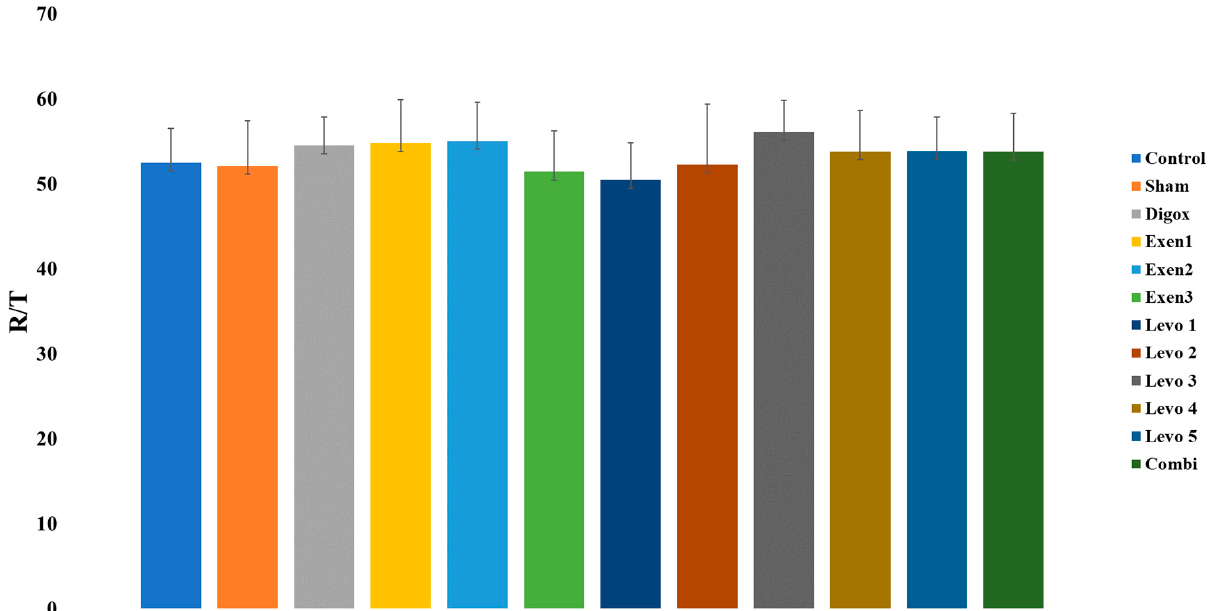
A one-way ANOVA was performed to assess possible differences of Ischemic Area/Risk Area (I/R) among groups. There was a significant main effect of group for I/R (F = 231.700, p < 0.001) (Table 16). In order to examine whether there are any statistically significant